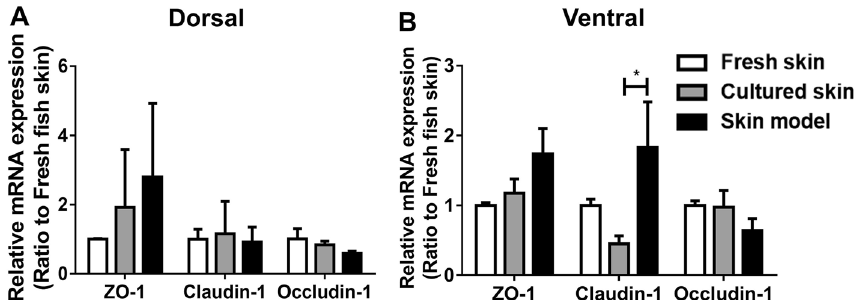
Figure 3. The mRNA expression level of tight junction components in the skin model. The mRNA expression level of ZO-1, Claudin-1 and Occludin-1 in cultured skin and skin model was relative to the expression of the fresh skin assigned a value of 1 [transcript abundance for each gene was normalized using housekeeping gene elongation factor 1-alpha (EF1-α)]. All data were shown as mean values (± SEM). Four fish and two replicates of tissue were used. Statistical significance was determined by using one-way ANOVA followed by Bonferroni post hoc test for comparison of expression between three conditions. *p ≤ 0.05.